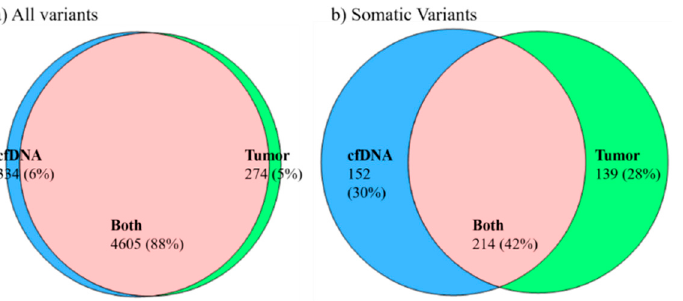
Figure 3. Variant concordance . Concordance between variants in tumor tissue and paired cfDNA.